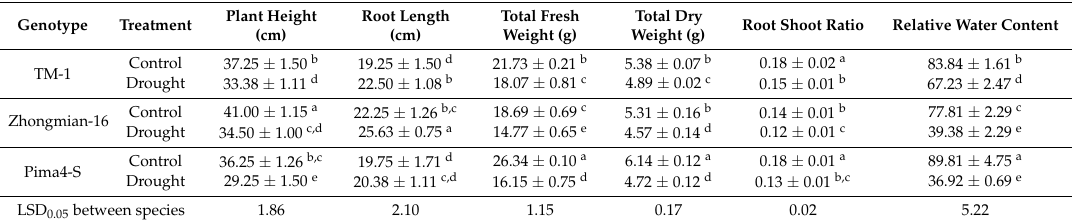
Table 1. Effect of drought stress on the growth parameters of three cotton species.